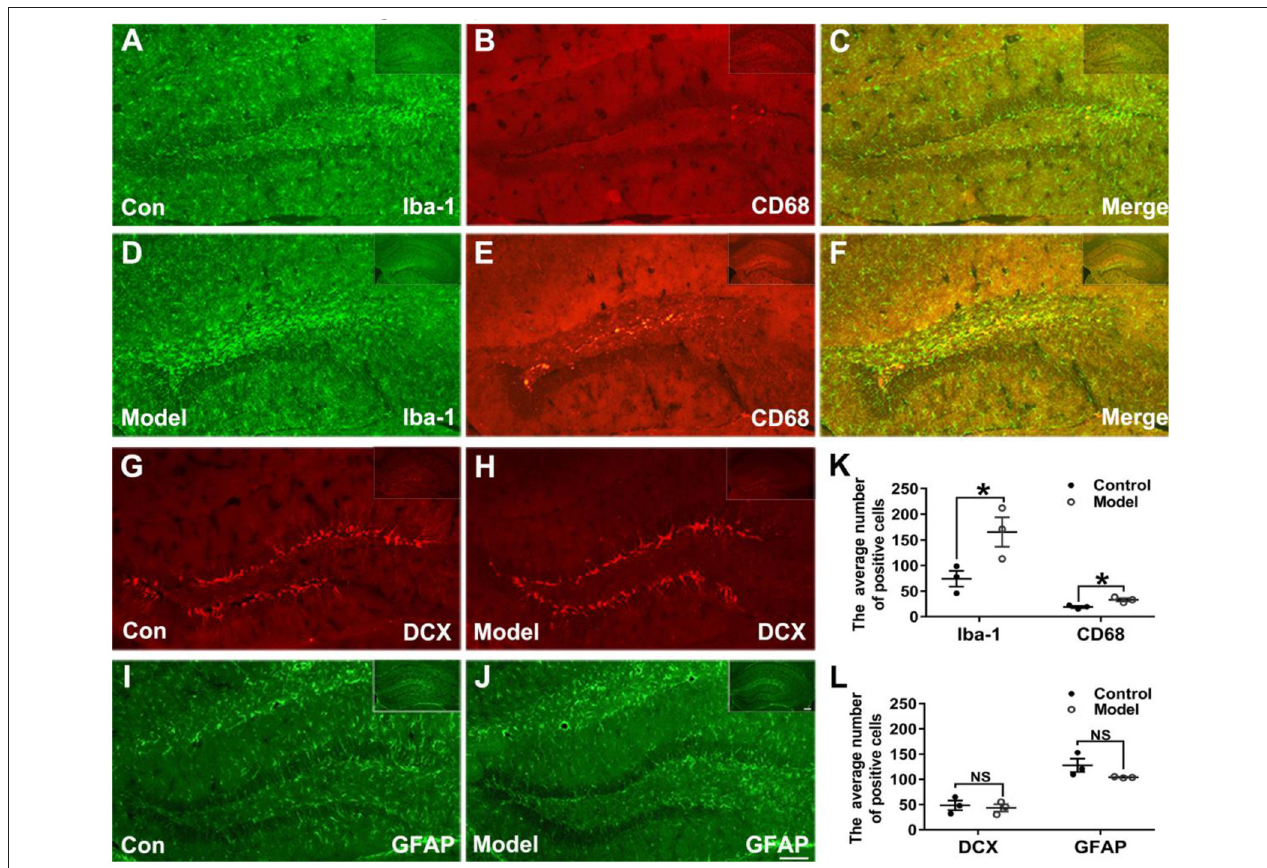
FIGURE 6 | Effects of bilaterally hippocampal injection of STZ on the activation of microglias in the dentate gyrus of hippocampus of mice. (A–F) shows immunofluorescent microscopy of Iba-1 (green) and CD68 (red) in hippocampus tissues and the dentate gyrus. (G–J) shows immunofluorescent microscopy of DCX (red) and GFAP (green) in hippocampus tissues and the dentate gyrus (DG). Compared with those in the control mice, the number of Iba-1 (A,D) and CD68 (B,E) positive microglia ascends significantly in the DG tissues of the model group (K) . There was no significant difference in the number of positive cells of DCX (G,H) and GFAP (I,J) between the two groups. The data in (K) and (L) are presented as the mean ± SEM, with 3 mice in each group. Scale bars = 100 µ m in J (applies to A–J ), 200 µ m in insets. * P < 0.05; compared with the control group, NS is no significance.